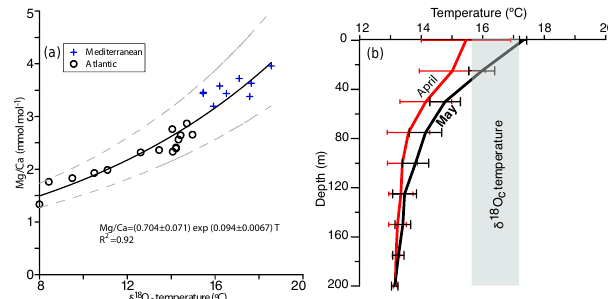
Figure 2. (a) Exponential function and correlation between δ 18 O c temperatures and Mg / Ca. Dashed lines show the 1 σ confidence limits of the curve fit. The standard error of our temperature cali- bration taking into account each δ 18 O c temperature from core tops (Table 1) is ± 0.6 ◦ C. Error of temperature estimates based on our G. bulloides calibration for the western Mediterranean is ± 1.4 ◦ C. These uncertainties are higher but still in the range of ± 0.6 ◦ C ob- tained for the Atlantic Ocean in Elderfield and Ganssen (2000) and also 1.1 ◦ C in G. bulloides culture data (Lea et al., 1999). (b) April (red) and May (black) temperature profiles of the first 200m mea- sured during years 1945–2000 in stations corresponding to the stud- ied core tops (MEDAR GROUP, 2002). The δ 18 O c average temper- ature of all cores is shown (grey, vertical